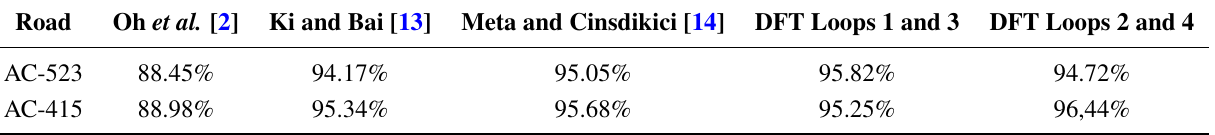
Table 3. Comparison with other related literature works in terms of success